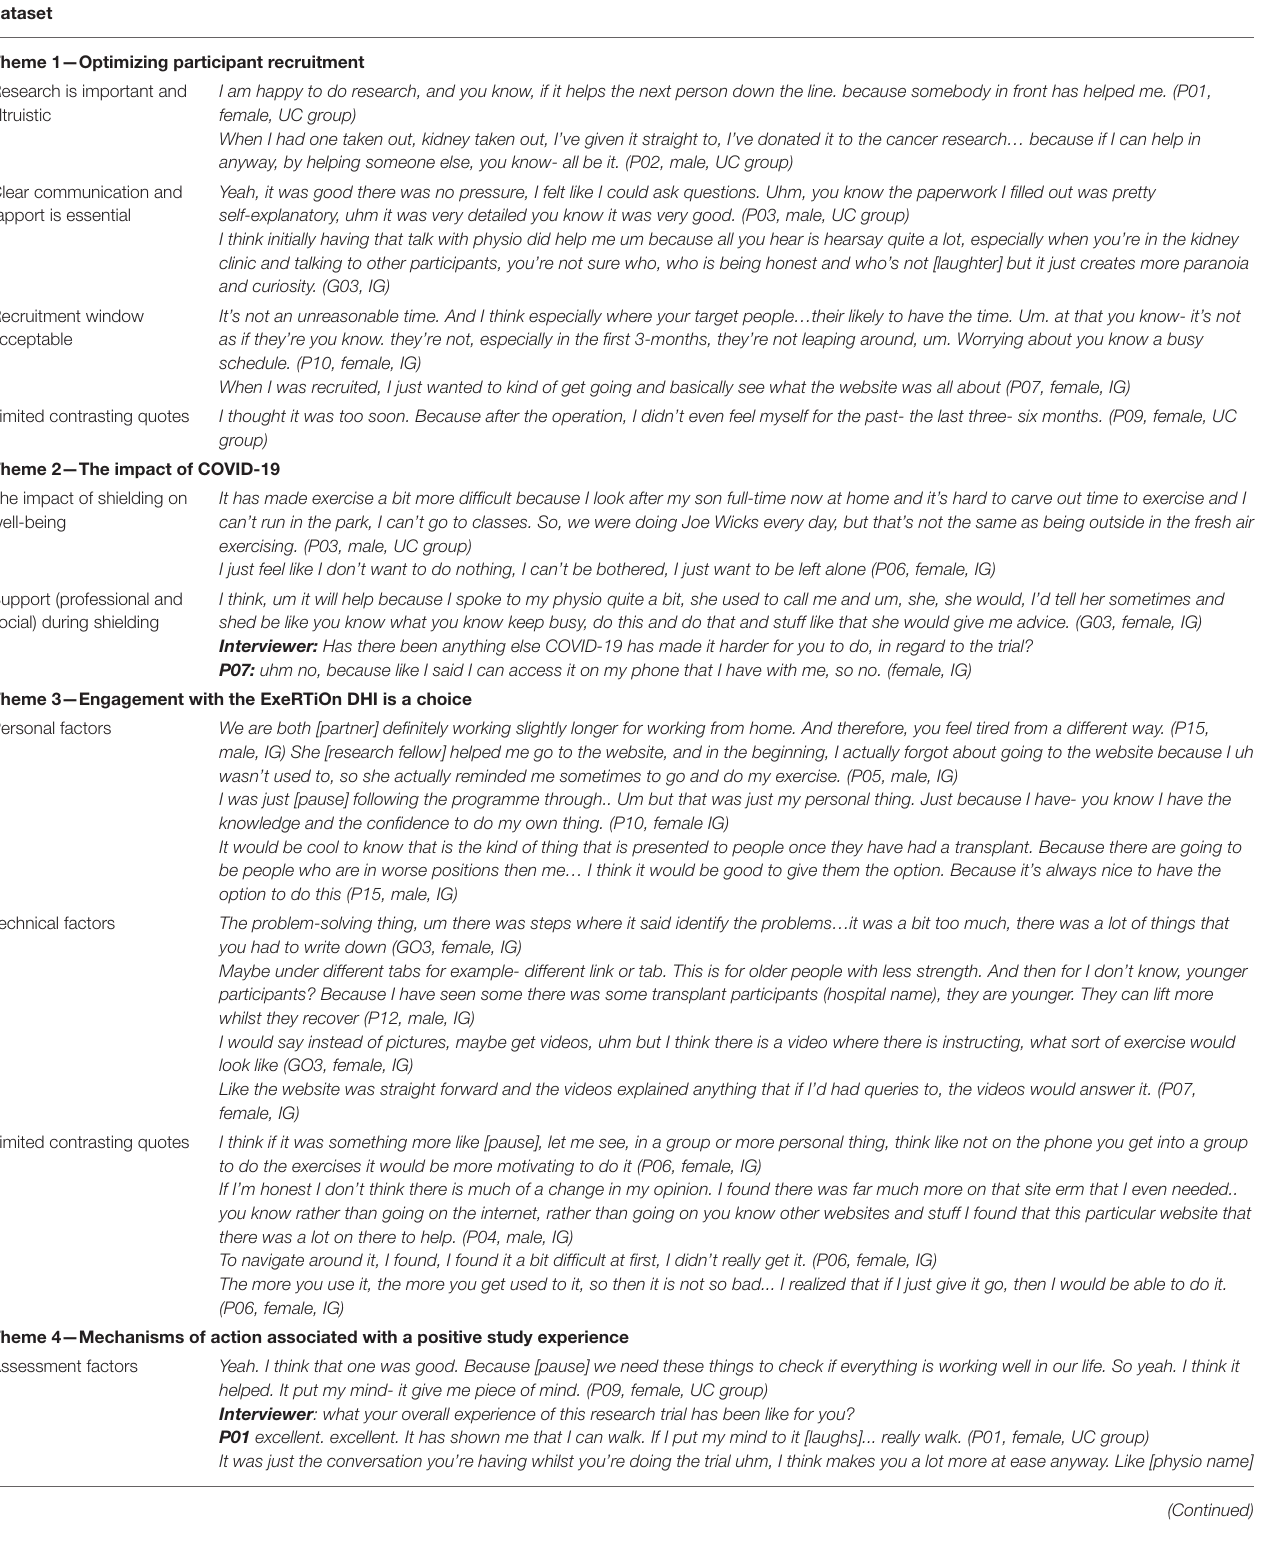
TABLE 4 | Themes relating to the acceptability, feasibility, and experience of both trial participation and the ExeRTiOn DHI with illustrative quotes. Subtheme/divergent quotes if evident from